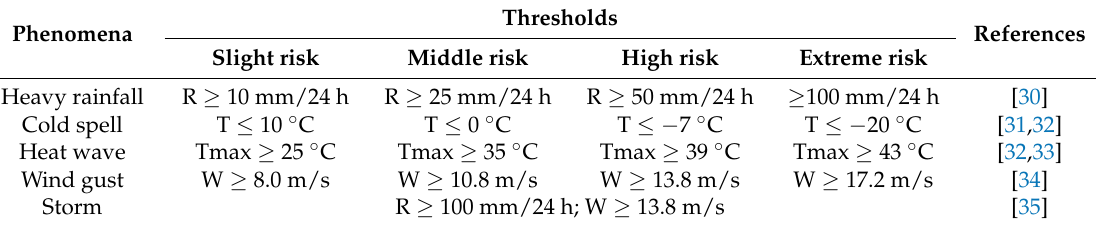
Table 2. The impact thresholds for different weather